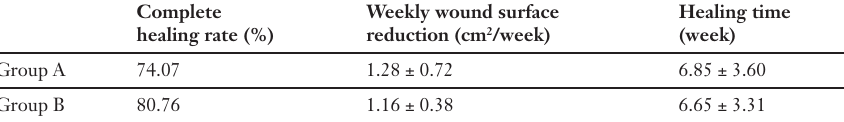
Demographic data, initial size of ulcers, previous ulcer dura- tion and previous ulcer recurrence (mean, average, SD).